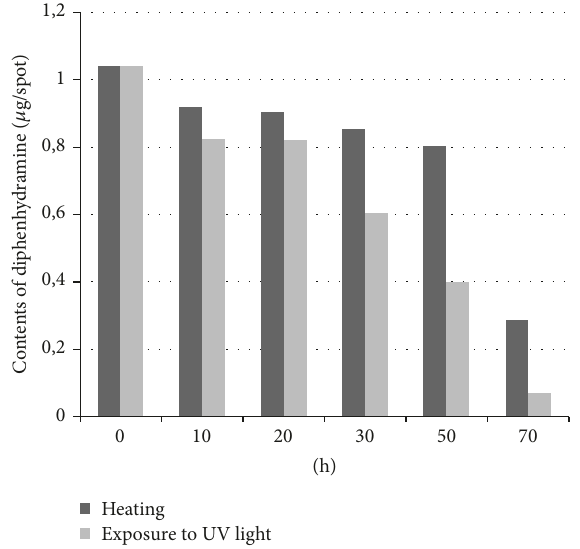
Figure 5: Changes of diphenhydramine contents in time during heating and exposure to UV